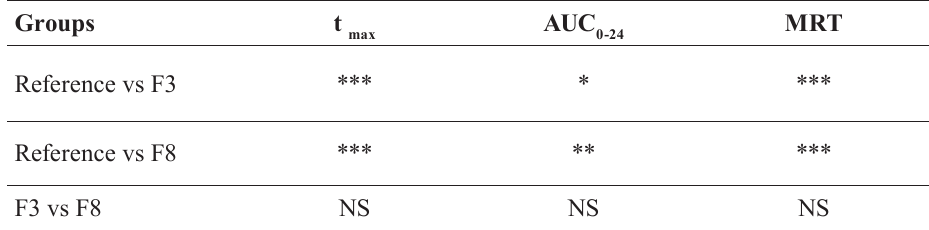
, AUC and MRT of max 0-24